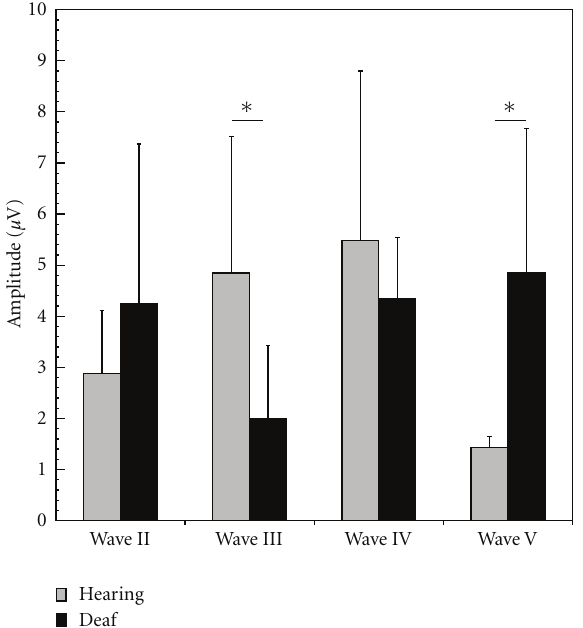
Figure 6: Wave mean peak amplitudes in matured animals (older than 3 months). In CDCs, wave III had lower and wave V higher amplitude (two-tailed t -test at α =